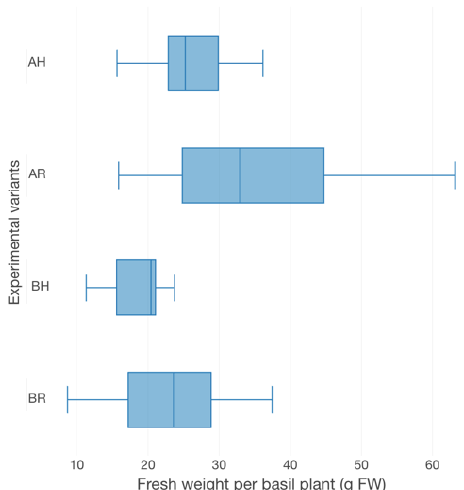
Figure 4. Boxplot for fresh weight per basil plant for each experimental variant, at the end of the